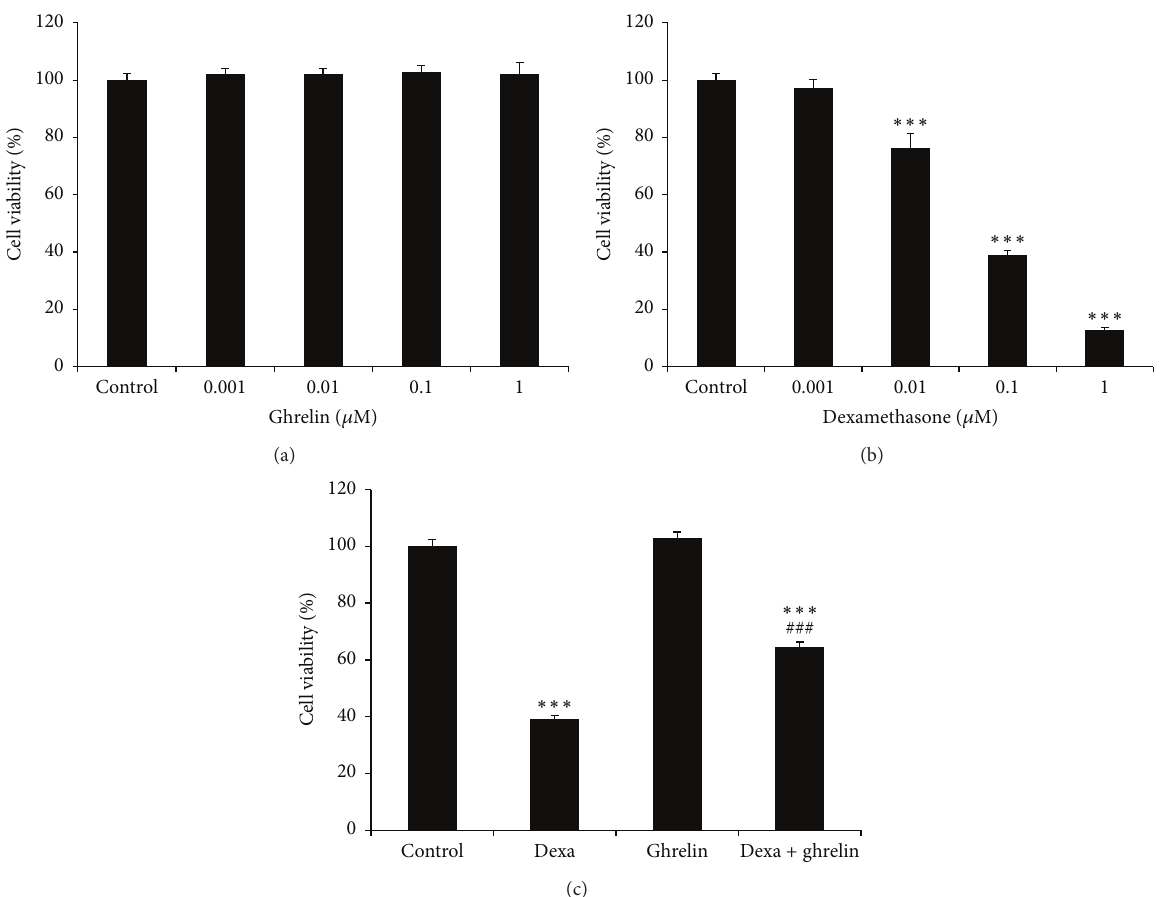
Figure 1: Effects of ghrelin and dexamethasone on INS-1 cell viability. (a, b) INS-1 cells were seeded at a density of 1 × 10 4 cells/well in 96-well plates and treated with 0.001–1 𝜇 M ghrelin or dexamethasone for 48 h. Cell viability was assessed using the MTS assay. (c) Ghrelin protects INS-1 cells from dexamethasone-induced cell apoptosis. INS-1 cells were incubated in complete medium (control), 0.1 𝜇 M dexamethasone, 0.1 𝜇 M ghrelin, and 0.1 𝜇 M dexamethasone + 0.1 𝜇 M ghrelin for 48 h. The Promega cell proliferation assay was used to determine the viability of INS-1 cells. The data are presented as the mean ± SD. ∗∗∗ 𝑝 < 0.001 versus control group; ### 𝑝 < 0.001 versus dexamethasone